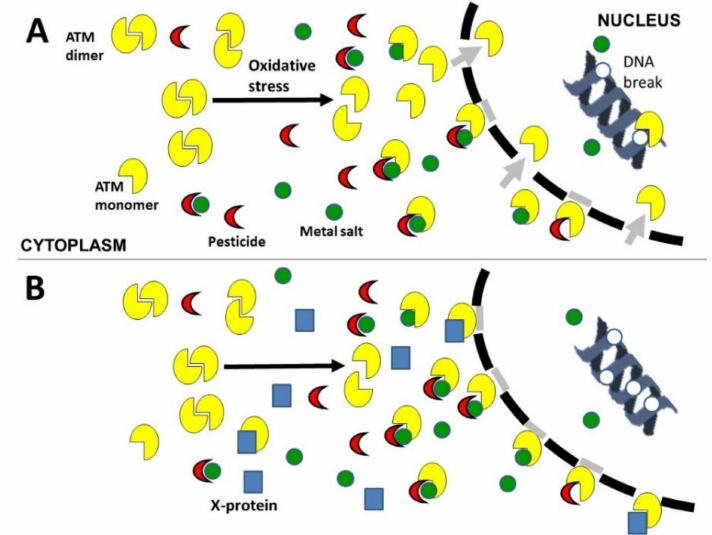
Figure 10. Mechanistic model of metal and pesticide action based on the nucleo-shuttling of the ATM protein. As detailed in discussion, the presence of metal and/or pesticide may produce a significant oxidative stress that contributes to monomerize ATM dimers and induce DSB. Some metal or pesticide molecules or metal+pesticide complexes may bind to ATM monomers and delay their nucleo-shuttling, limiting therefore the DSB recognition by the NHEJ pathway. There are two possible consequences: either DSB are unrepaired, which triggers cell death and toxicity, or DSB are misrepaired by an alternative DSB repair pathway, which triggers genomic instability and carcinogenicity. Panels A and B describe the model in RIANS-normal ( A ) or RIANS-delayed ( B )